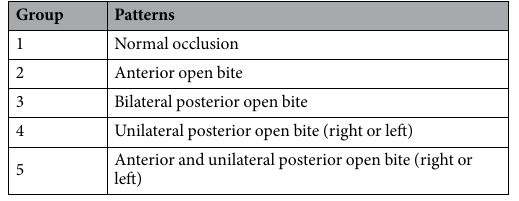
Table 3. T-Scan occlusal patterns in pre-surgical